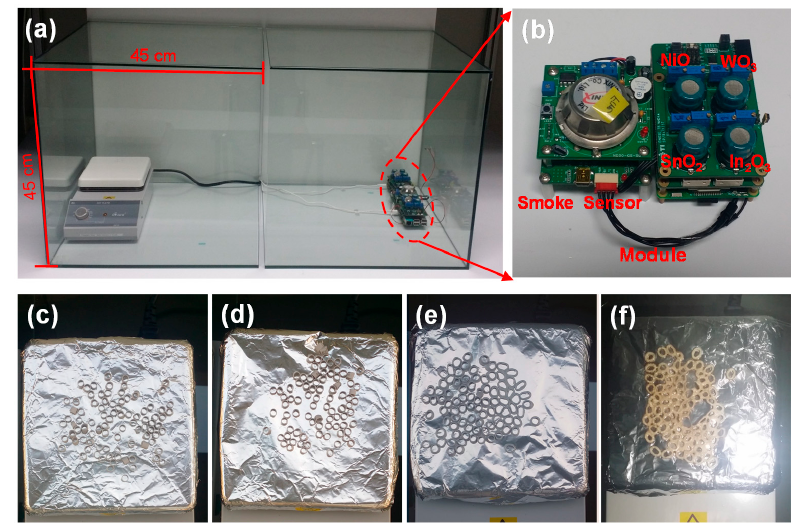
Figure 5. Photographs of test environment and results; ( a ) a chamber for gas-sensing measurement and ( b ) the signal processing circuits with the integrated sensors; ( c – f ) PVC deformation at varying hot-plate temperatures (50 °C, 100 °C, 200 °C and 350 °C).